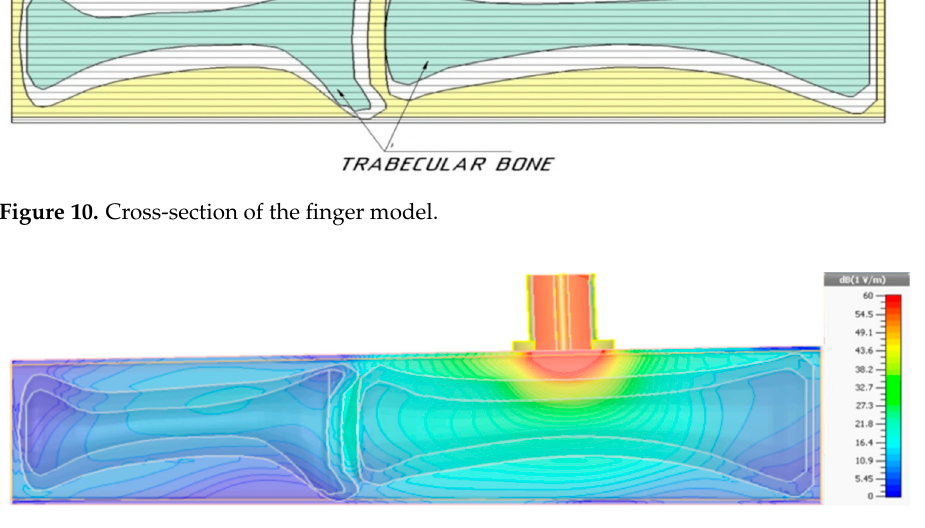
Figure 10. Cross-section of the finger model.